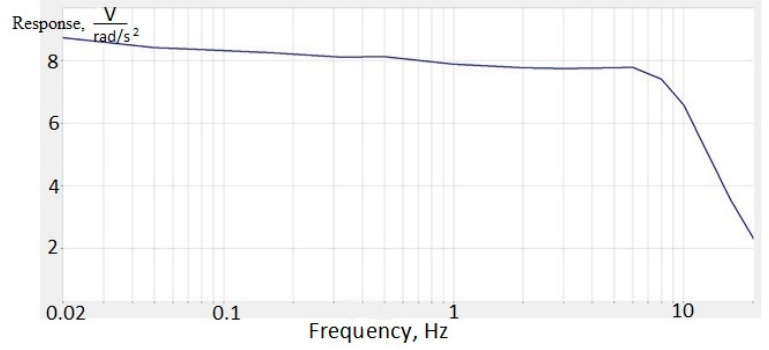
Figure 9. The amplitude frequency response for molecular–electronic angular accelerometer with negative MHD feedback.